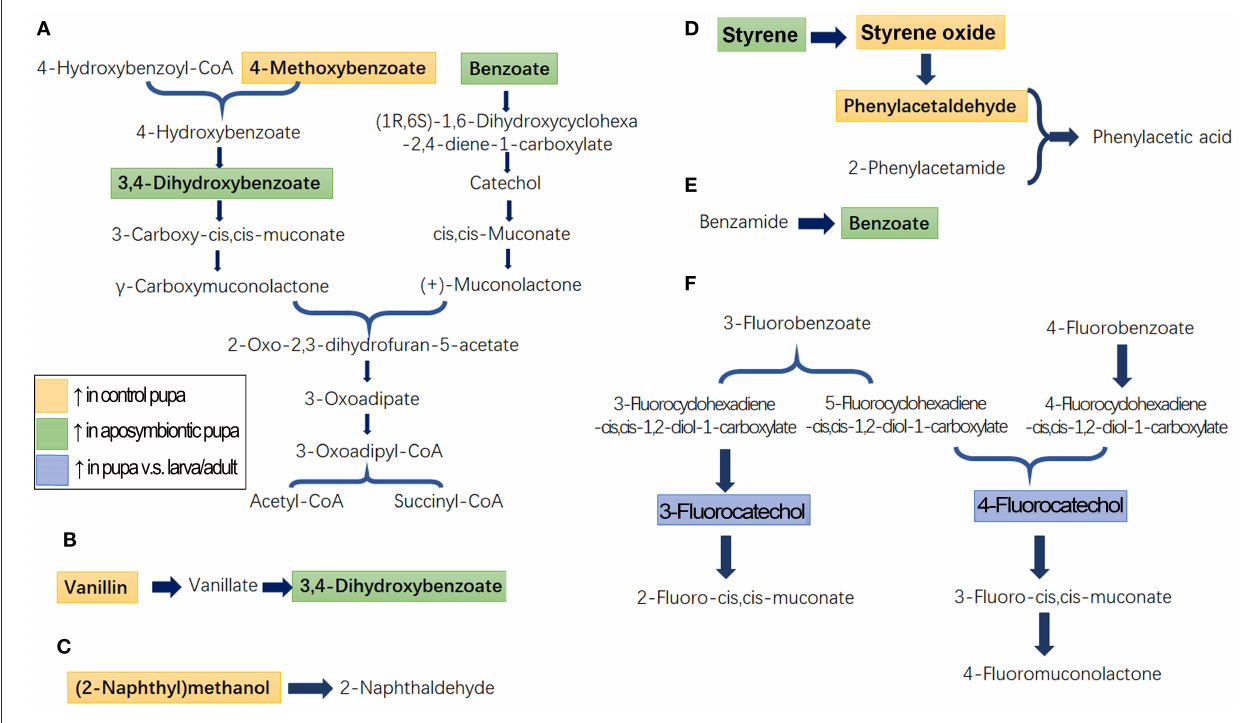
FIGURE 4 | Schematic diagram of the disturbed metabolic pathways in pupae. A total of seven active pathways were enriched in the pupal specimen by KEGG (http://www.kegg.jp) analysis. These ways were associated with the biodegradation of benzoate and 4-methoxybenzoate (A) , vanillin (B) , naphthalene (C) , styrene (D) , benzamide (E) , and fluorobenzoate (F) . The light orange and light green boxes indicate metabolites significantly higher and lower in the control pupal group than in the antibiotic-fed group, respectively. The light blue boxes mark metabolites significantly higher in the pupal group than in the larval and adult